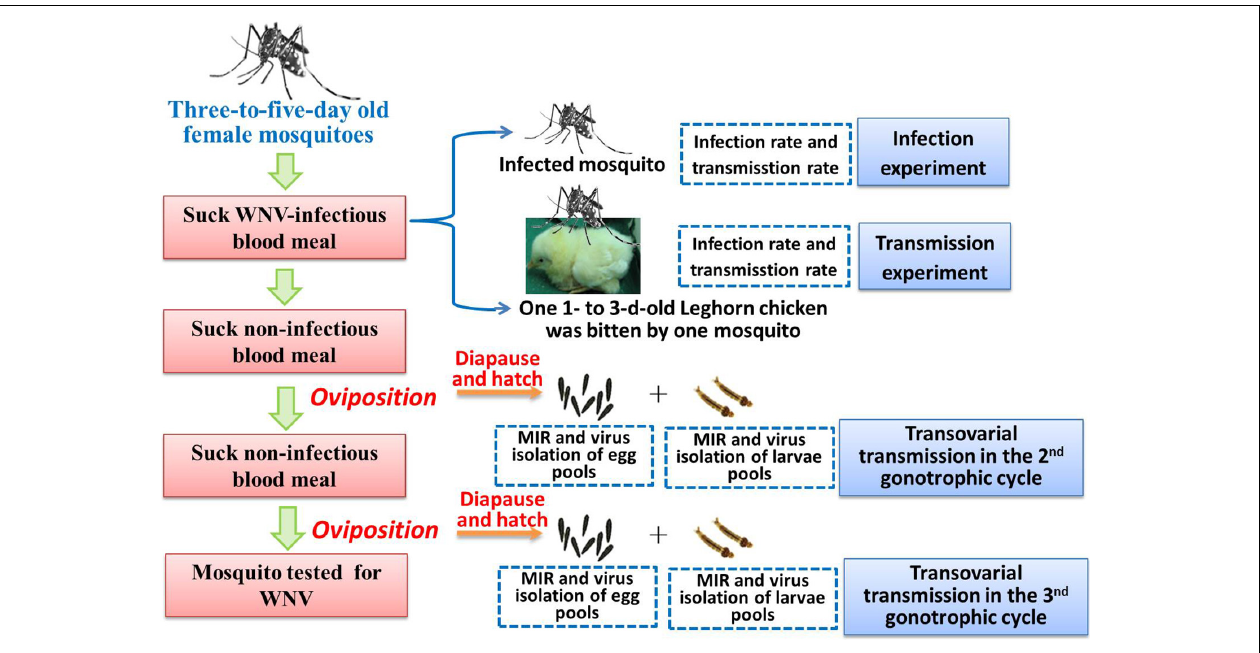
FIGURE 1 | A schematic representation of the experimental design.